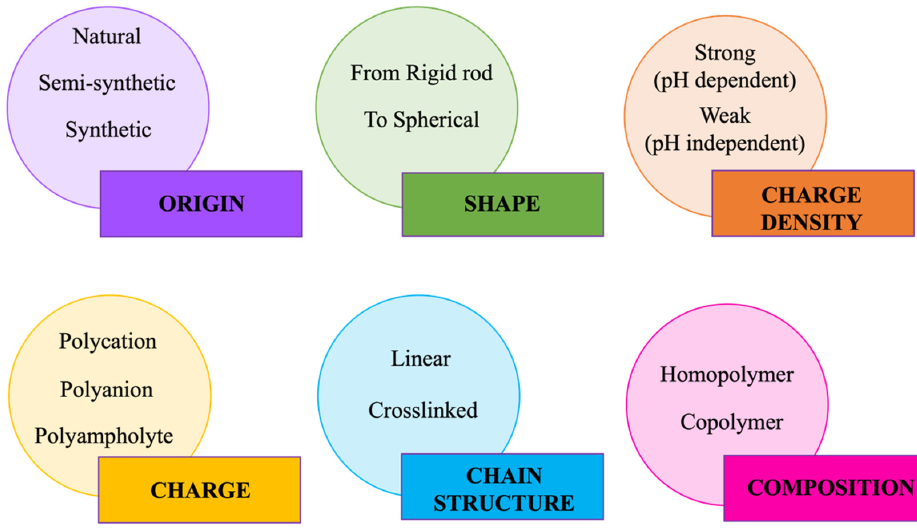
Figure 1. Classification of polyelectrolytes (Polys).